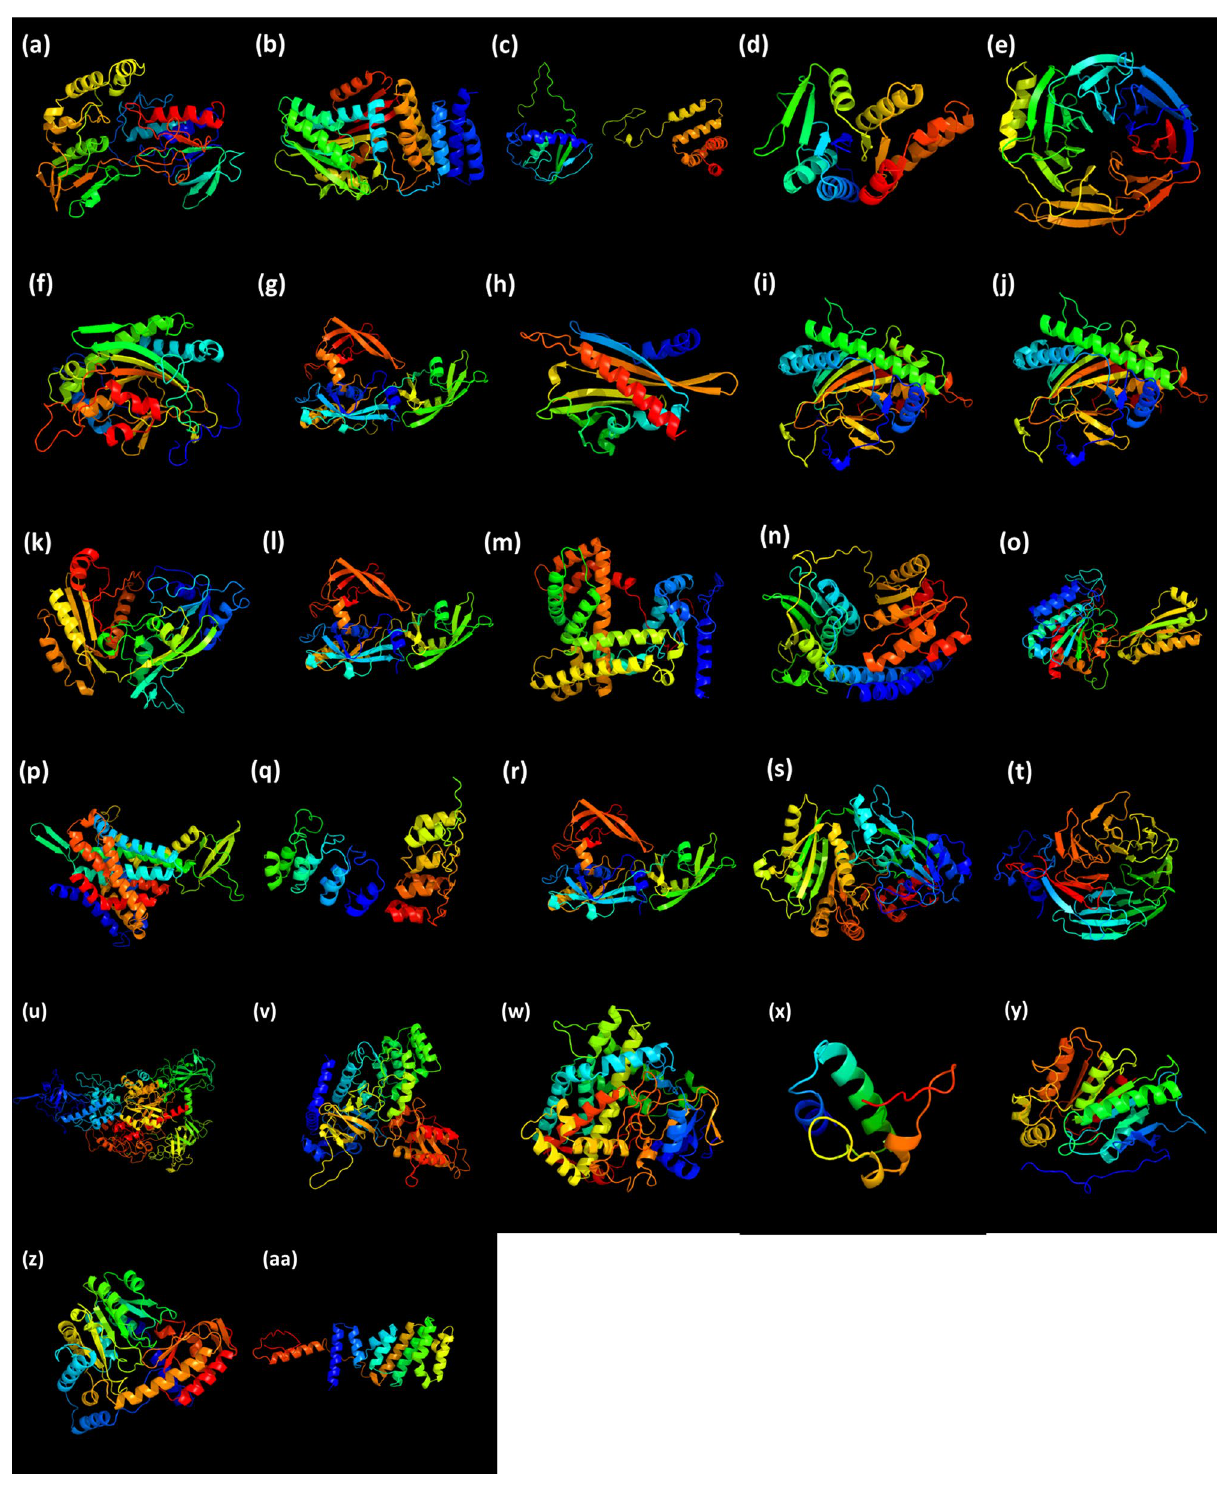
Figure 6. Predicted structures of proteins with 100% confidence level for the genes ( a ) CsYUCCA ( b ) CsDELLA ( c ) CsFIS2 ( d ) CsLOG ( e ) CsFIE ( f ) CsGA20OX ( g ) CsARF8 ( h ) CsPYR1 ( i ) CsGA2ox1 ( j ) CsGA20OX2 ( k